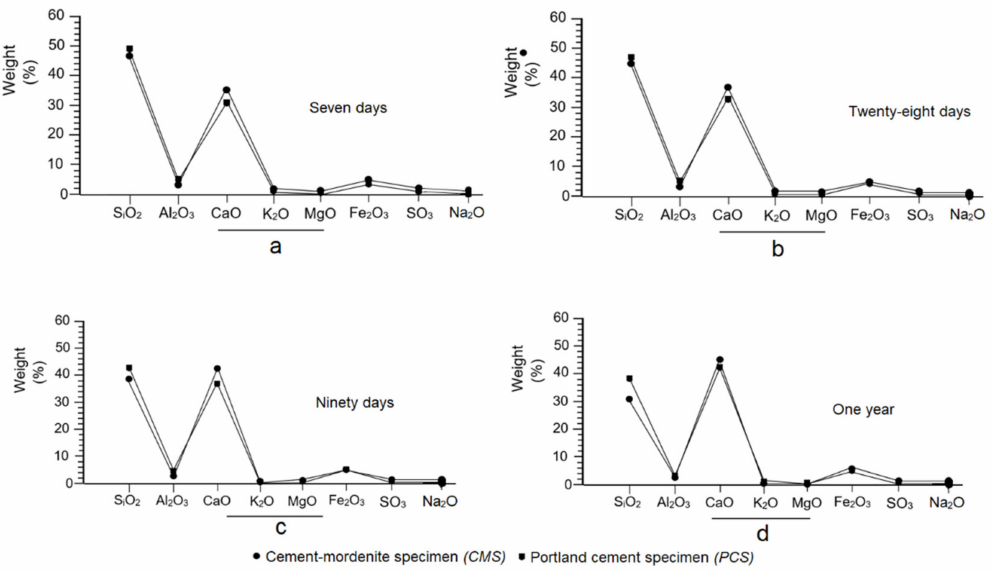
Figure 19. Behaviour of major compounds in cement/mordenite (CMS) and portland cement (PCS) specimens at different ages: ( a ) at 7 days, ( b ) at 28 days, ( c ) at 90 days and ( d ) 1